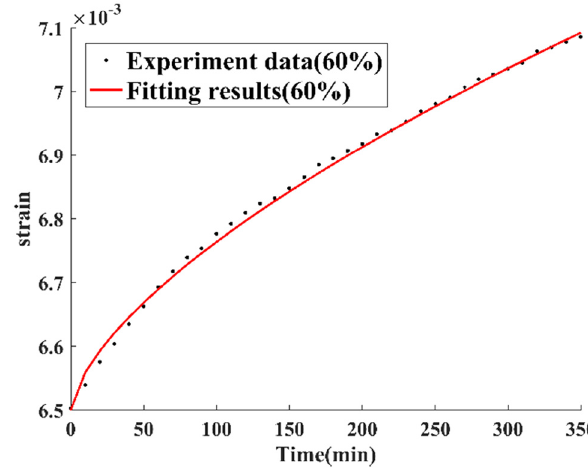
Figure 15: Fitting results based on the fractional de fi ned Maxwell model and 40% stress level.